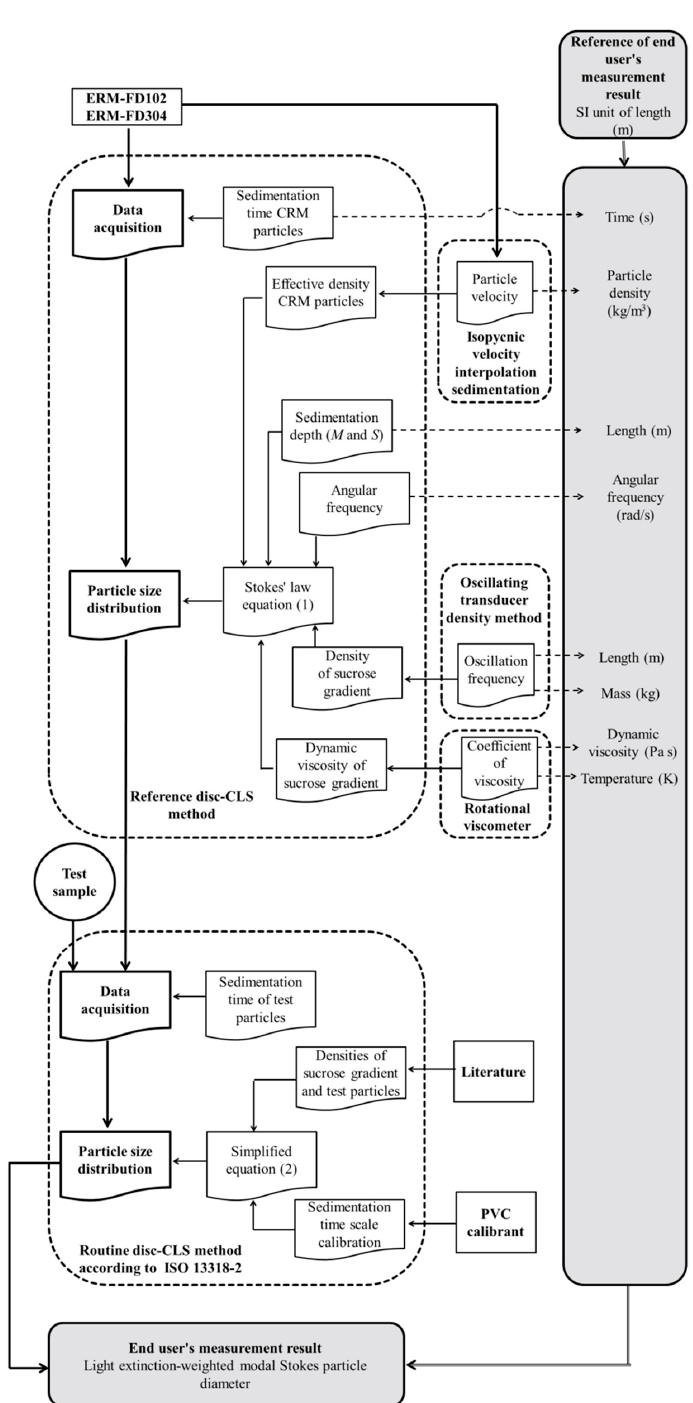
Figure 4. Metrological traceability network linking a particle size measurement result of a test sample obtained by the routine disc-CLS method (after calibration with PVC reference particles) to the SI unit of length (meter) via particle size results of silica CRMs obtained by the reference disc-CLS method.